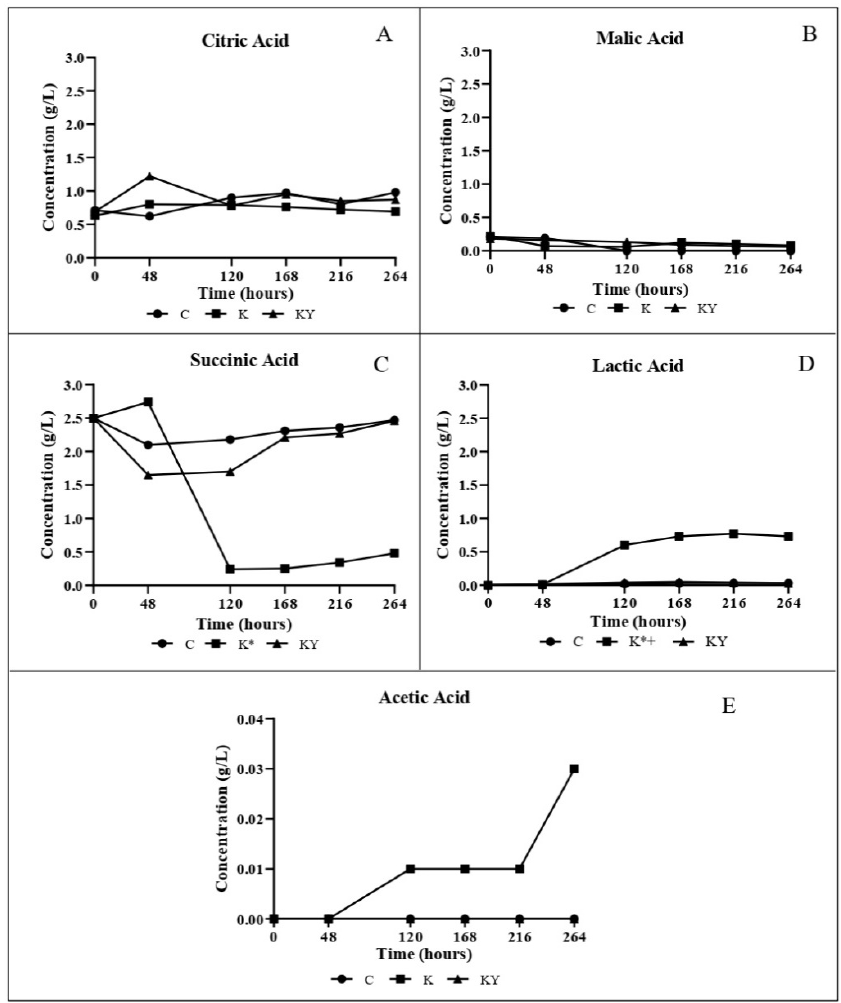
Figure 3. Evaluation of lactic acid ( A ), malic acid ( B ), succinic acid ( C ) and citric acid ( D ) during 264 h of fermentation in the C, KY and K assays. Acetic Acid ( E ). C: Control, K: kombucha, KY: kombucha + commercial brewer yeast. * Significant difference ( p < 0.05) between C and K assays; +, significant difference ( p < 0.05) between K and KY